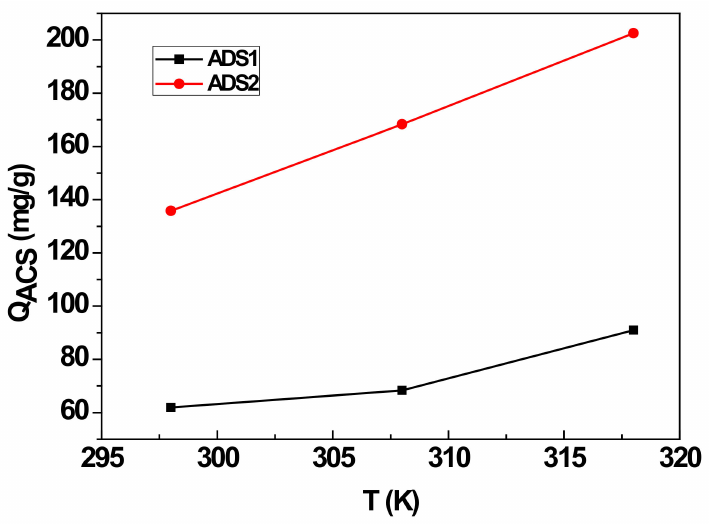
Figure 2. Impact of temperature on ACS of TTCCN for both the